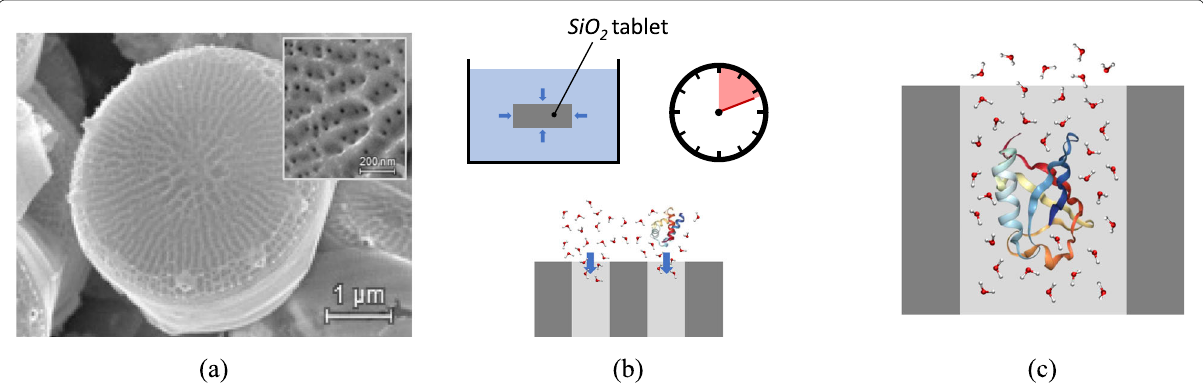
Fig. 1 Bio-inspired conceptualization of the nano-metering silica tablets. a Scanning electron microscopy of Thalassiosirapseudonana , showing the whole valve and the detail of the porous nanochannels in the insert. Image adapted from [26] and used under CC BY 4.0 license. b Starting from nanopores initially empty, the water molecules and solvated proteins tend to intrude into the silica nanotablets with a characteristic filling time. c Detail of the intrusion of ubiquitin (1UBQ) in a silica nanopore, resulting in reduced mobility of the water molecules due to the electrostatic interactions with the protein and nanopore